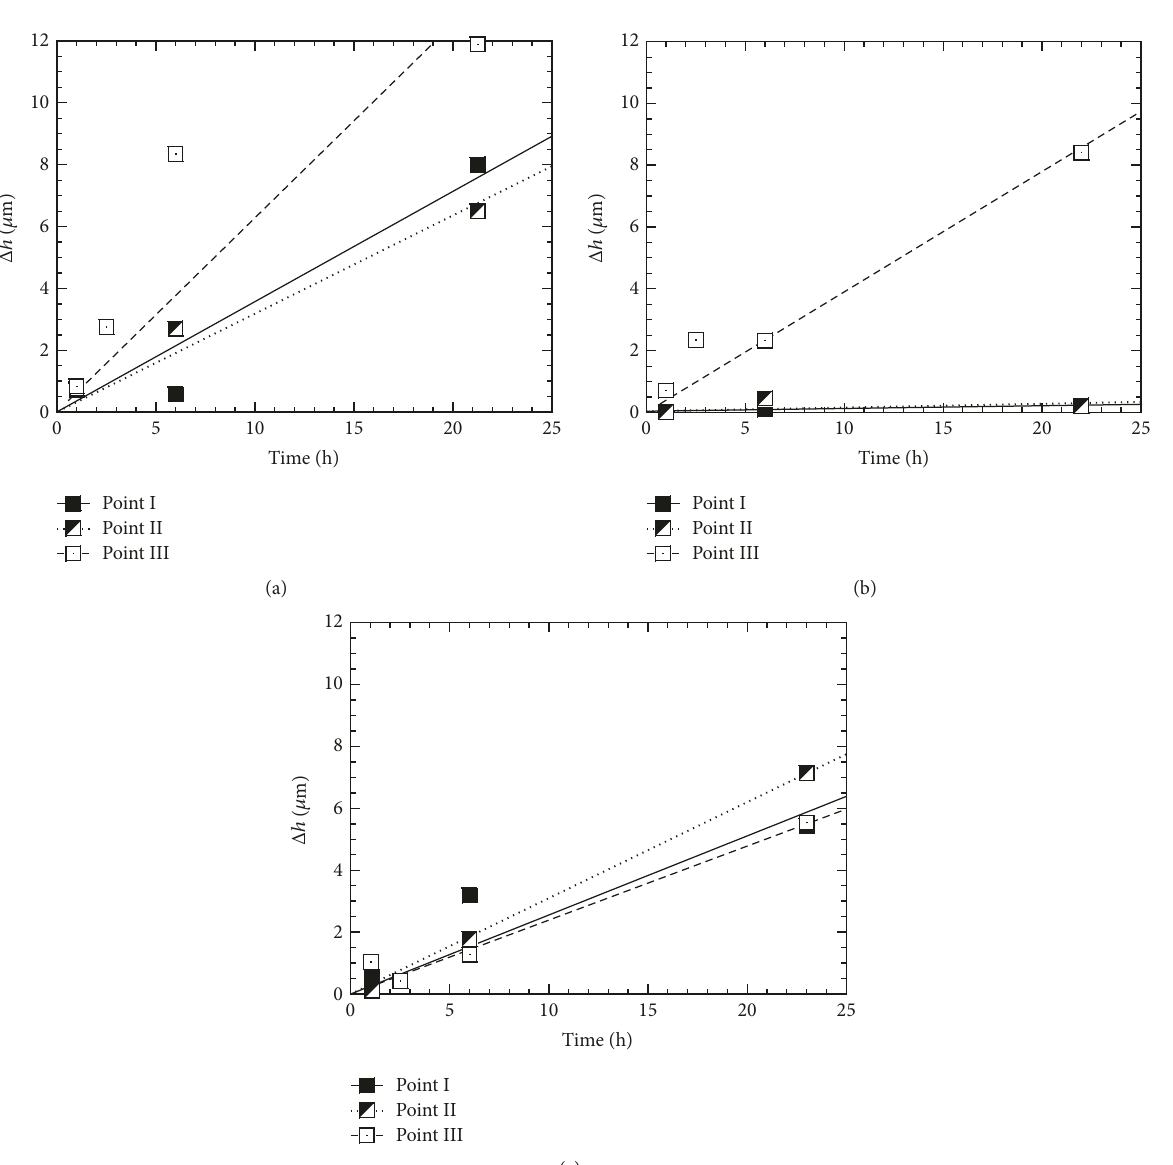
Figure 4: Time course change of Δℎ of aragonite in each run: (a) Run A, (b) Run B, and (c) Run C. Each line corresponds to a linear approximation passing through the